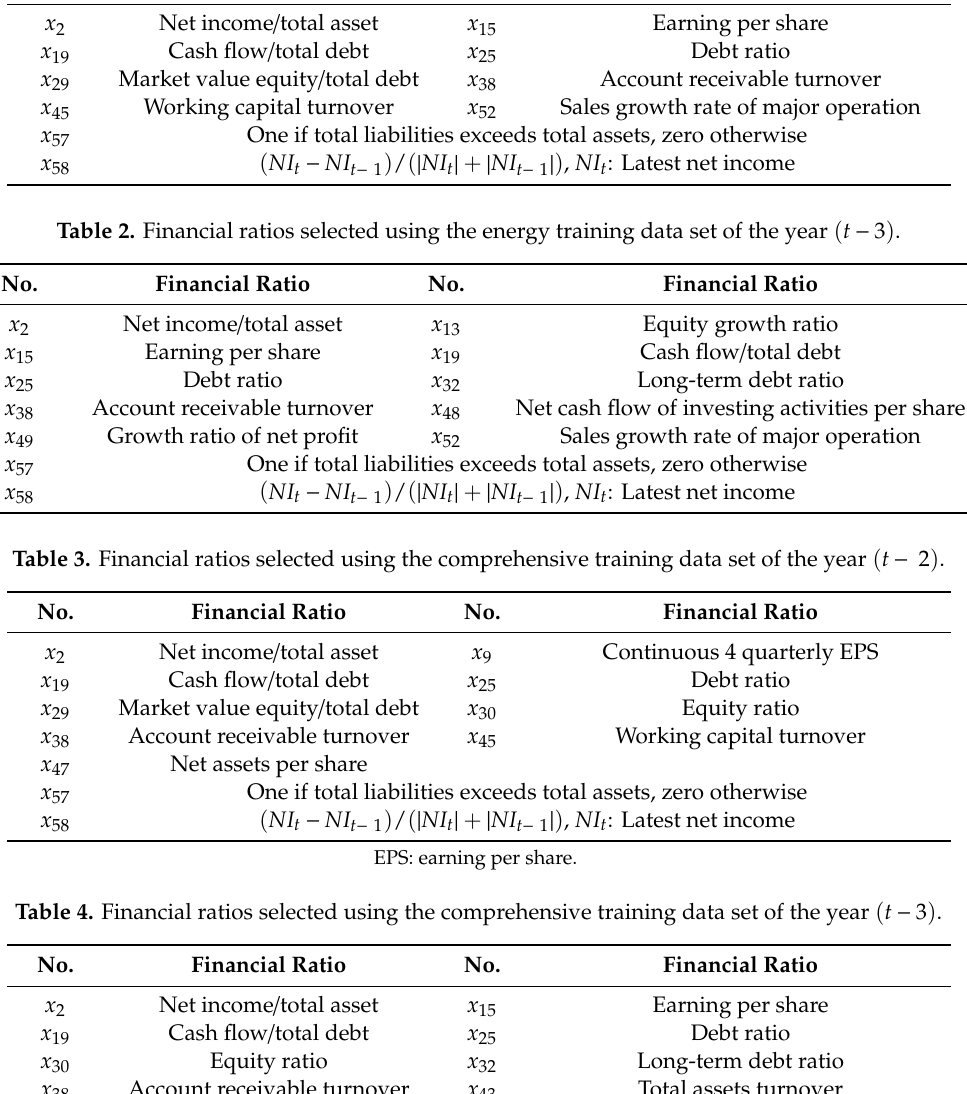
Table 1. Financial ratios selected using the energy training data set of the year ( t − 2 ) . No.